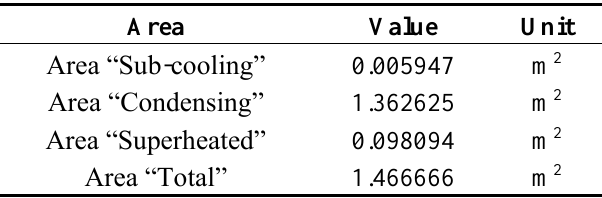
Table 9. Area of heat